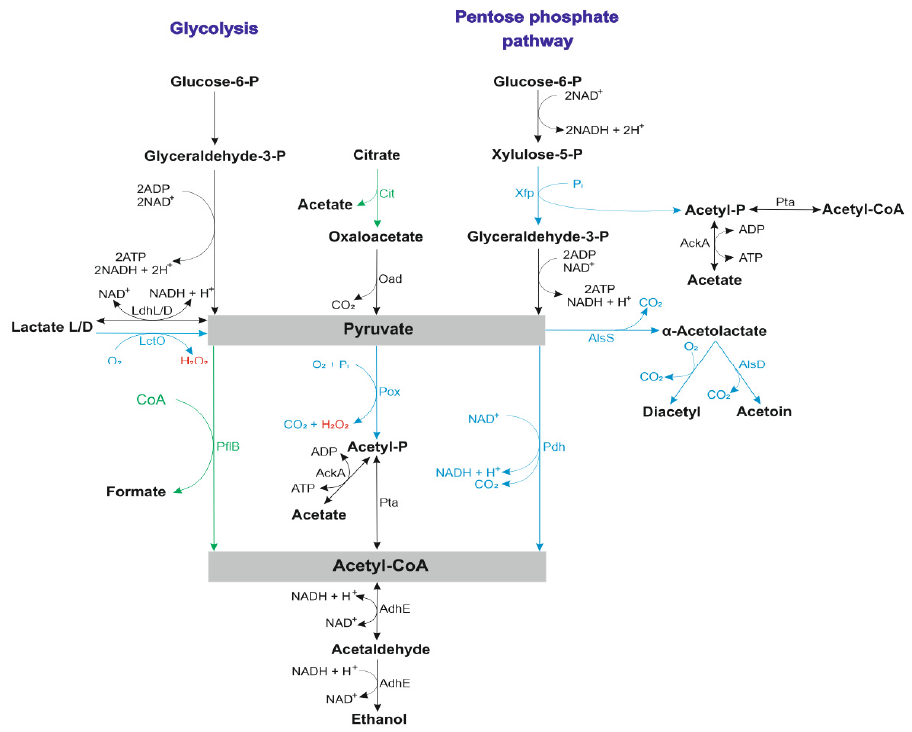
Figure 2. Pyruvate conversion pathways in L. rhamnosus CM MSU 529. LdhL/D, lactate dehydro- genase; LctO, lactate oxidase; Cit, citrate lyase; Xfp, phosphoketolase; AckA, acetate kinase; Oad, oxaloacetate decarboxylase; Pox, pyruvate oxidase; PflB, pyruvate formate lyase; Pta, phosphate acetyltransferase; Pdh, pyruvate dehydrogenase complex; AlsS, α -acetolactate synthase; AlsD, α - acetolactate decarboxylase; AdhE, acetaldehyde/alcohol dehydrogenase. Upregulated enzymes are in blue, downregulated enzymes are in green (Tables 1, S1 ‒ S3), and other identified enzymes are in black (Table S4).